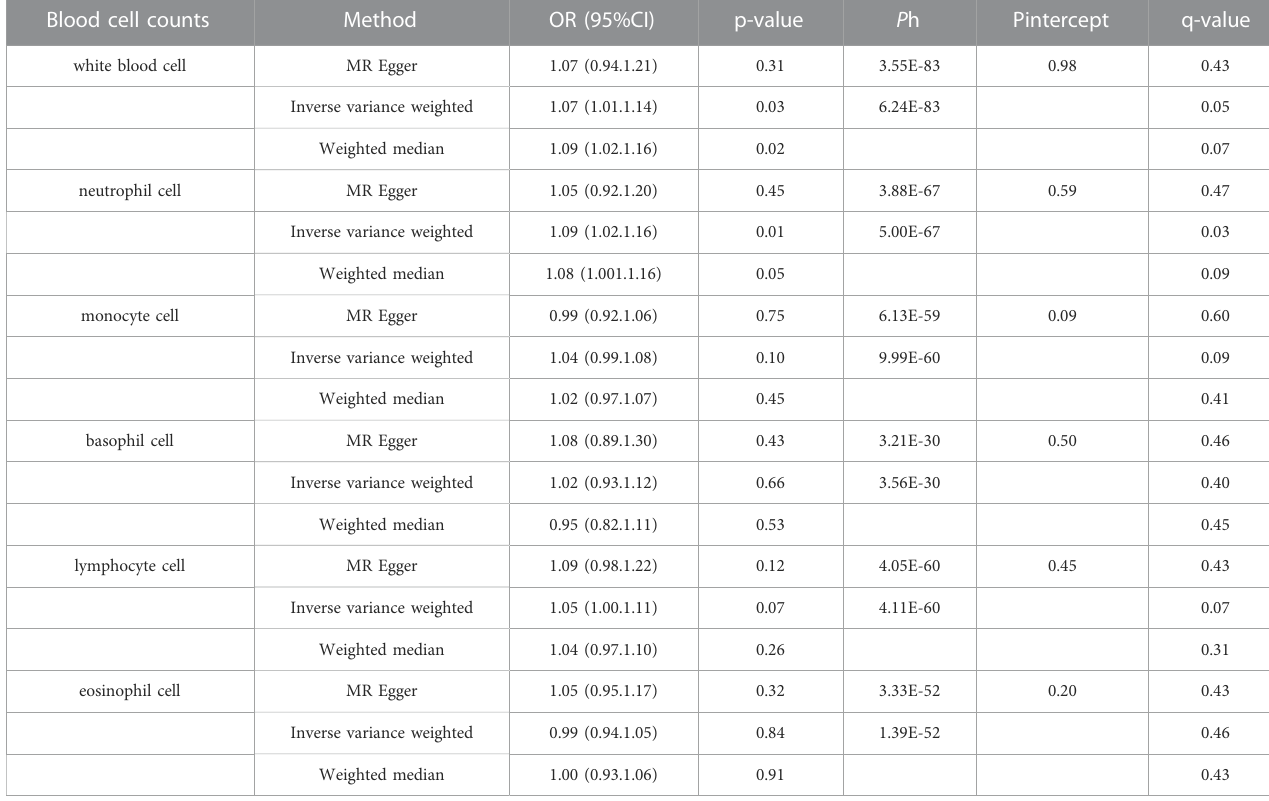
TABLE 2 Two-sample Mendelian randomization estimations showing the effect of blood cell counts on the risk of coronary heart disease. Blood cell